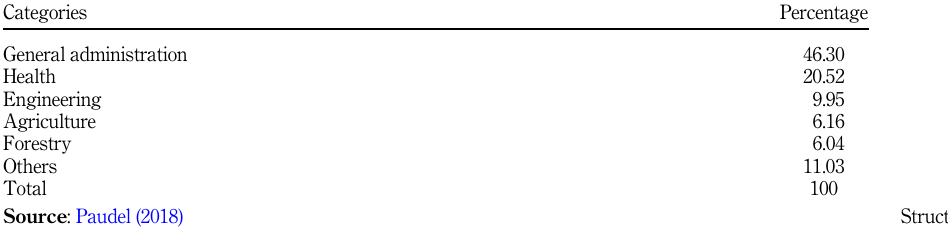
Table 5. Structure of the NCS